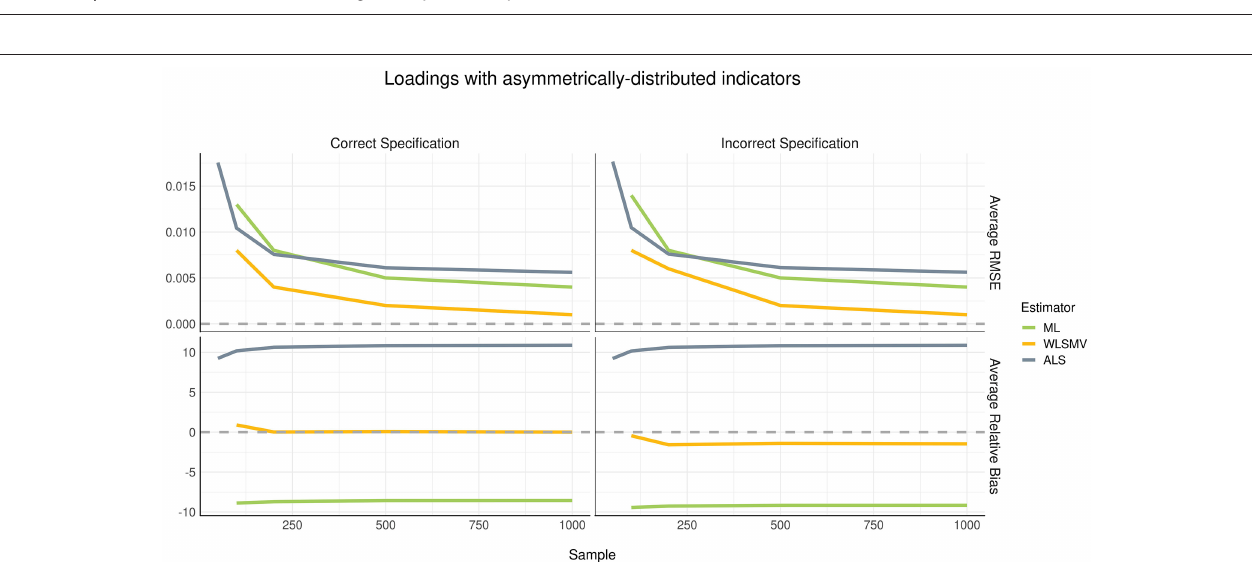
FIGURE 2 | Estimation error and bias in loadings with symmetrically distributed indictors.